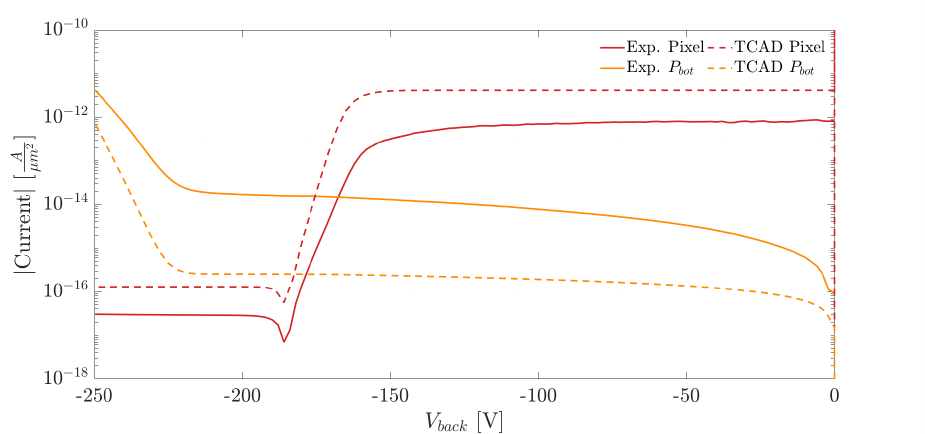
Figure 14. Comparison of the current densities obtained from measurements and simulations for a substrate thickness of 300 µ